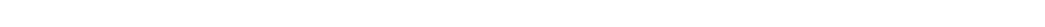
FIGURE3 the groups, are represented in panel E . Blue dots and box plots indicate HFD groups, and yellow dots and box plots indicate dietary change to LFD. Table displays the individual groups, respectively. Table is read from top to bottom; “+” denotes implementation of a given diet or intervention and “ − ” its absence. Significance of differences between groups was tested with either the Kruskal–Wallis test, followed by Dunn’s post hoc test for multiple comparisons (B) , the Brown–Forsythe test, and Welch’s ANOVA with the Tamhane T2 post hoc test for multiple comparisons [ D: F value ( F ) = 8.297, degree of freedom (DF) = 5, or by ordinary one-way ANOVA with Tukey’s post hoc test for multiple comparisons ( E: F = 9.765, DF = 5)]. Data are presented as mean ± SD, and statistical significance was set at p < 0.05. HFD, high-fat diet; LFD, low-fat diet; TM, treadmill; TRF, time-restricted feeding.